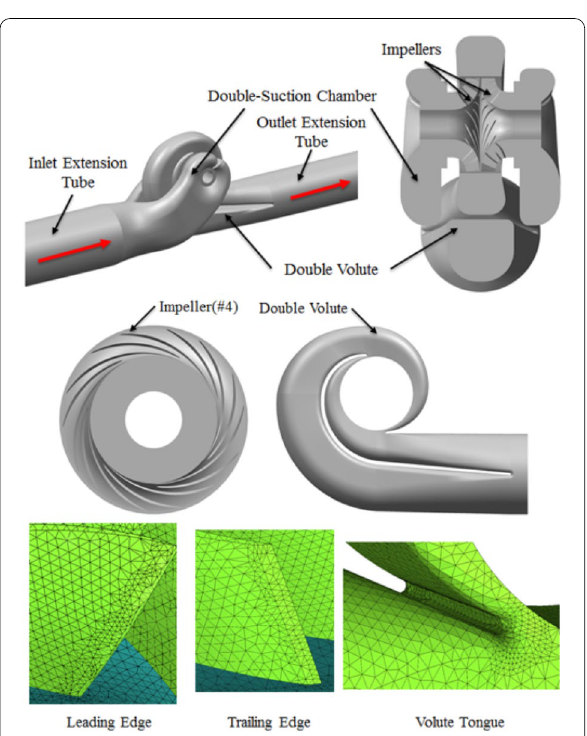
Figure 3 Computational domain and grid of the pump with splitter